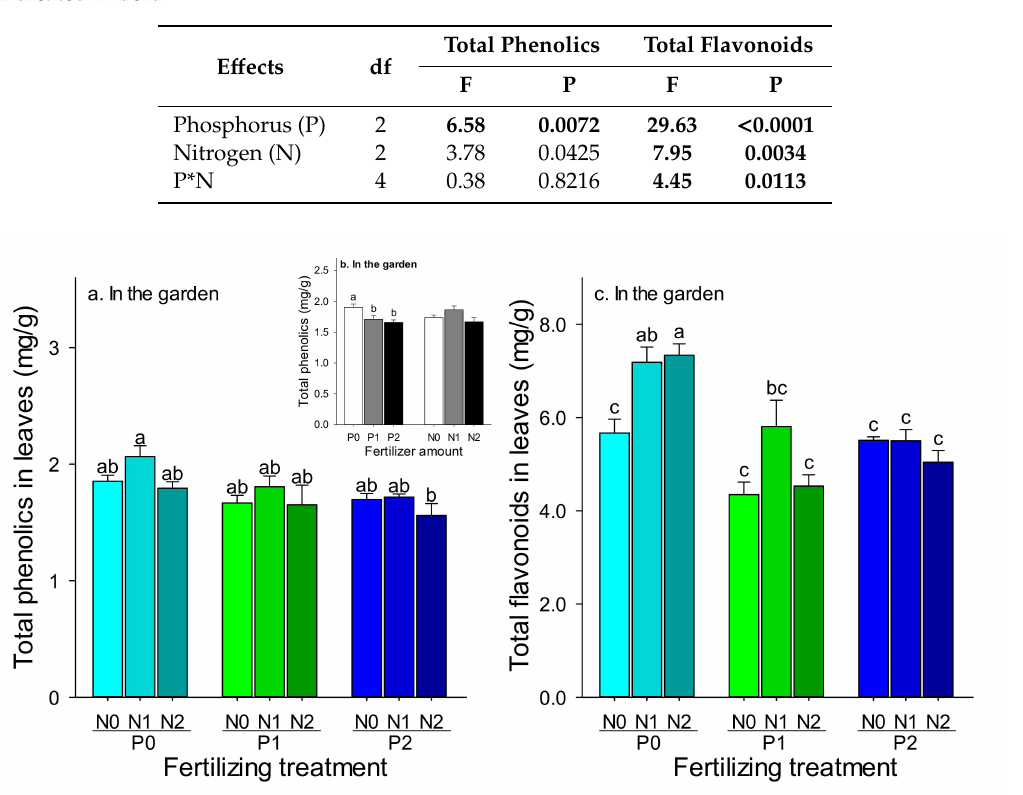
Table 4. The dependence of total flavonoids and total phenolics on the amounts of phosphorus (P0, P1, P2) and nitrogen (N0, N1, N2) fertilization and their interaction in the garden. Significant results are indicated in bold.